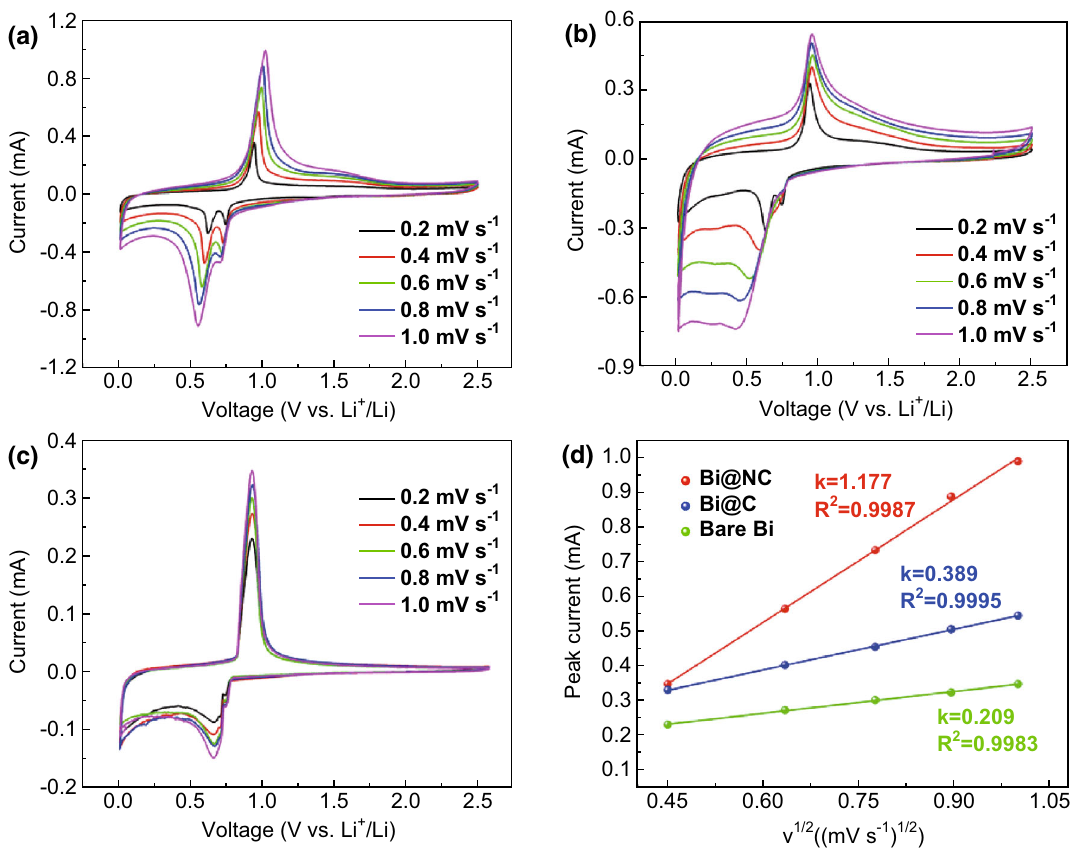
Fig. 7 CV characteristics of a Bi@NC, b Bi@C and c bare Biat scanning rates ranging from 0.2 to 1.0 mV s - 1 . d Linear relations of anodic peak currents ( i p ) versus the square roots of scanning rate ( t